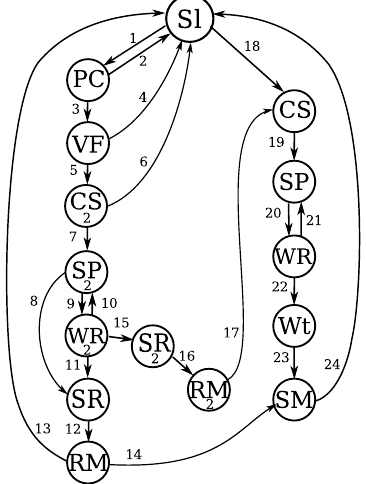
Figure 3. PAX-MAC state